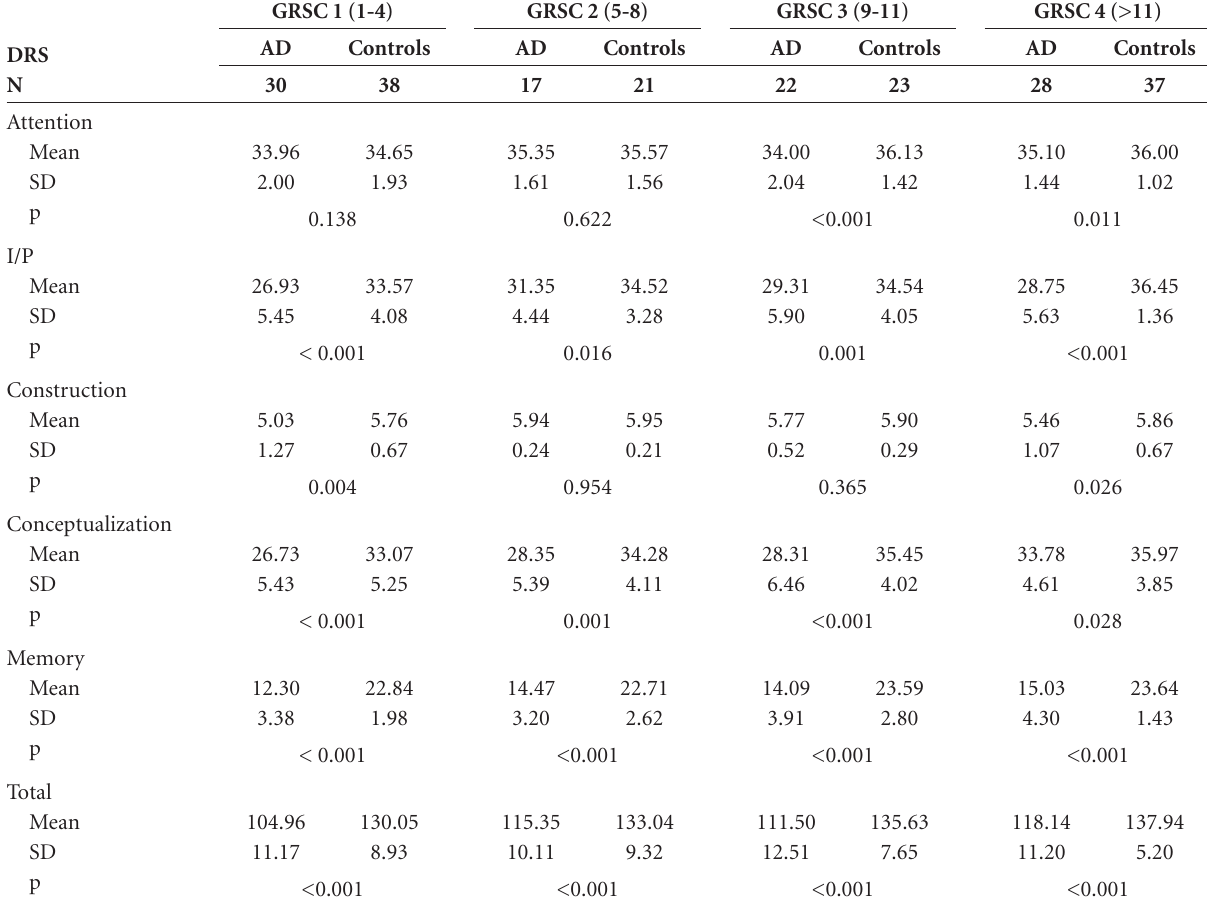
Table 2. Performance of AD patients and controls by schooling group on DRS total and